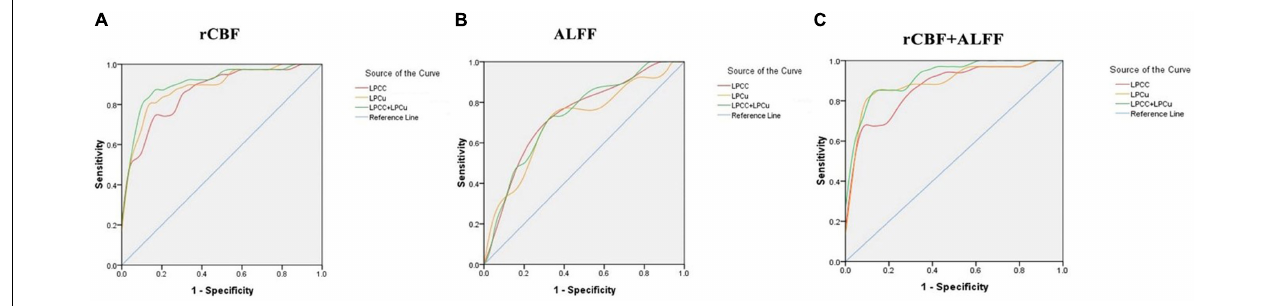
FIGURE 6 | (A) Receiver operating characteristic (ROC) curve for uncorrected rCBF in PCC/PCu of patients with AD and healthy controls. An optimal rCBF cutoff value was determined at a sensitivity of 87.2% and specificity of 86.7%. The area under the curve (AUC) for the ROC was 0.908 (95% confidence intervals from 0.836 to 0.979). (B) ROC curve for ALFF in PCC/PCu of patients with AD and healthy controls. An optimal ALFF cutoff value was determined at a sensitivity of 65.7% and specificity of 73.1%. The AUC for the ROC was 0.734 (95% confidence intervals from 0.608 to 0.861). (C) ROC curve for uncorrected rCBF combined with ALFF in PCC/PCu of patients with AD and healthy controls. When using the two values simultaneously, it can reach a sensitivity of 85.3% and specificity of 88.5%. The AUC for the ROC was 0.921 (95% confidence intervals from 0.855 to